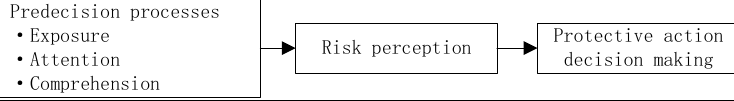
Figure 1. Psychological Processes of PADM.